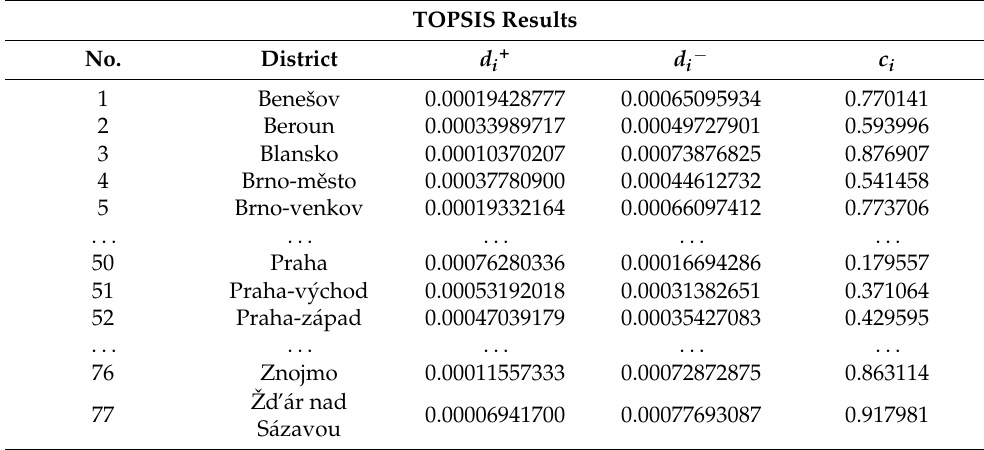
Table A7. TOPSIS results for 3rd area—selected